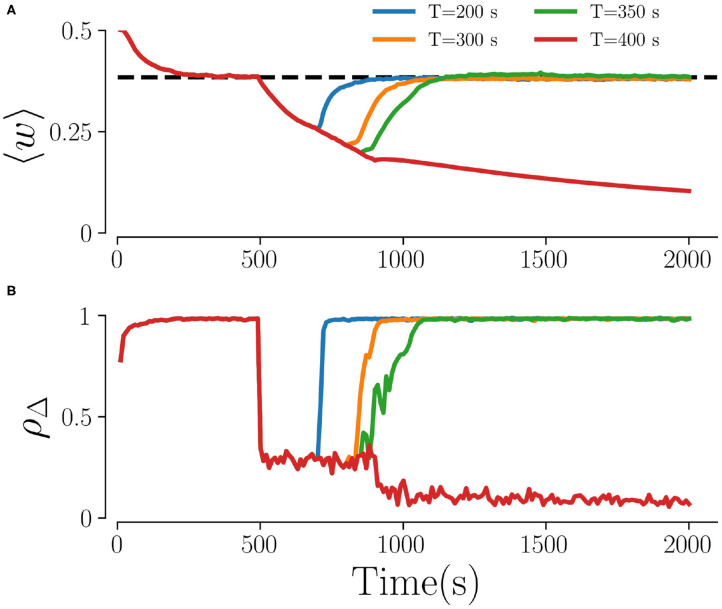
Time traces for different stimulation durations. (A) The mean weights, 〈w〉, and (B) the order parameter, ρΔ, for four different stimulation durations T. The dashed line in (A) characterizes the weights in the stable synchronized state. Here, fRR = 10 Hz, Astim = 1, L = 5, and M = 32. The Kuramoto order parameter in (B) is calculated every 10 s by averaging over non-overlapping time windows Δ = 10 s.